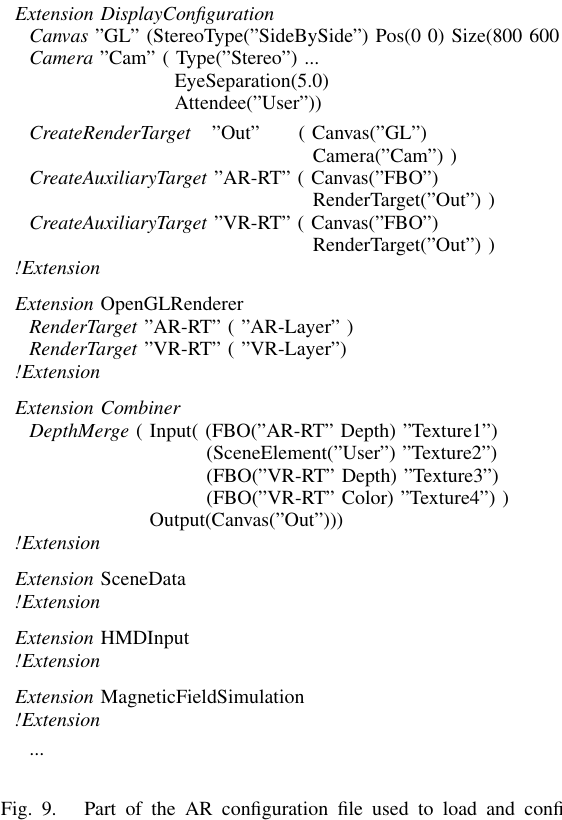
Part of the AR configuration file used to load and configure all needed plug-ins. Extension DisplayConfiguration Canvas ”GL” (StereoType(”SideBySide”) Pos(0 0) Size(960 1050 )